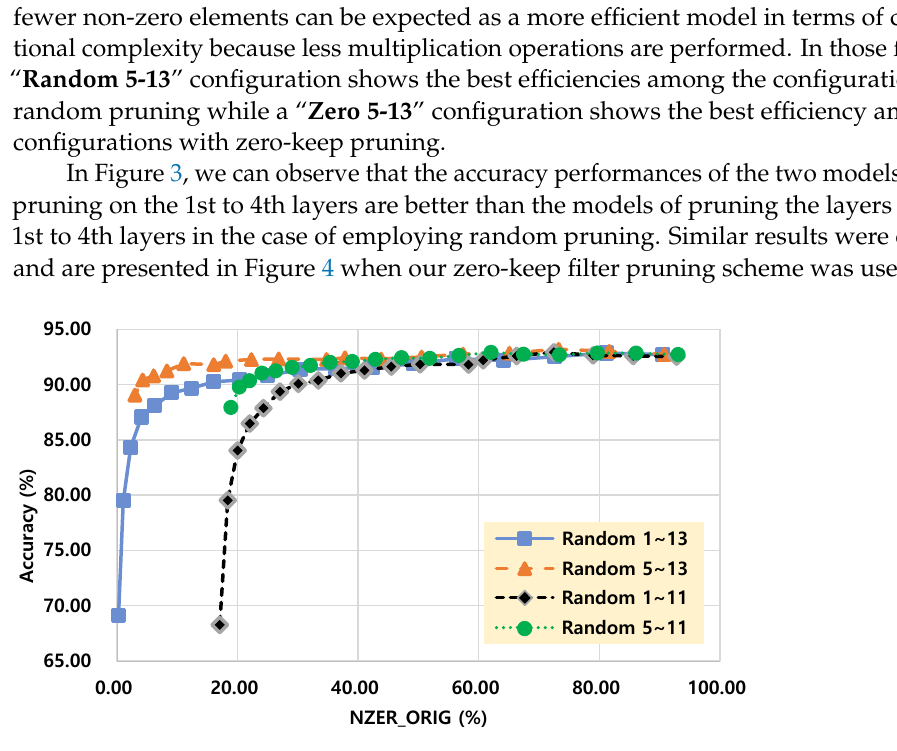
Figure 3. Non zero element rate versus accuracy trade-off of random filter pruning on VGG-16.